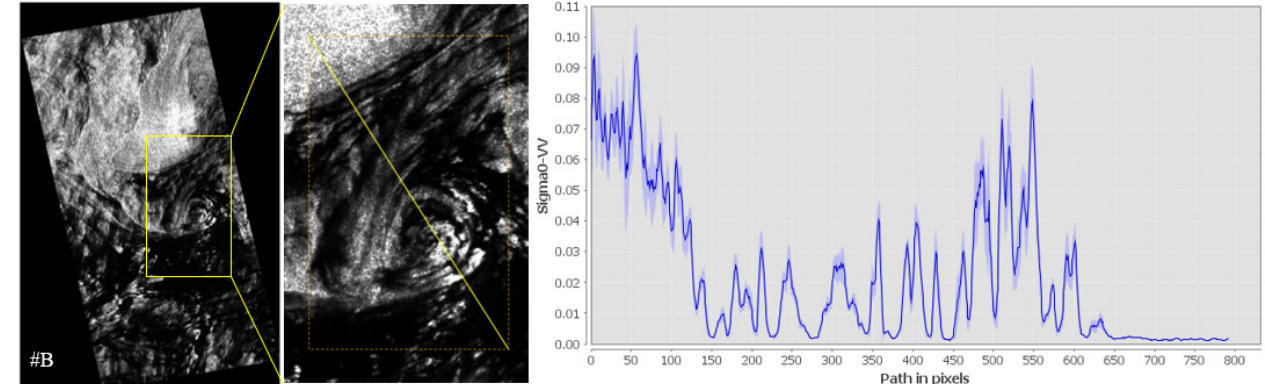
Figure 8. Backscatter profiles along scan lines through the B-E .